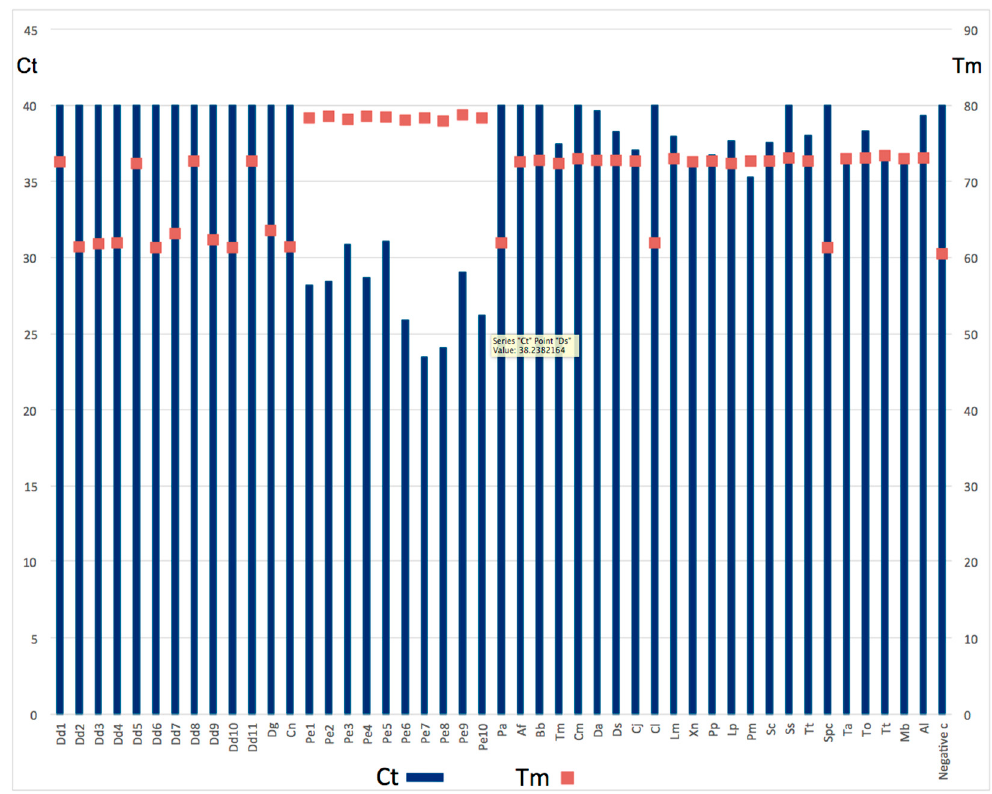
Figure 8. Real-Time PCR. Threshold cycles (Ct) on the left and melting temperature (Tm) on the right. Abbreviations as in Tables 2–4.